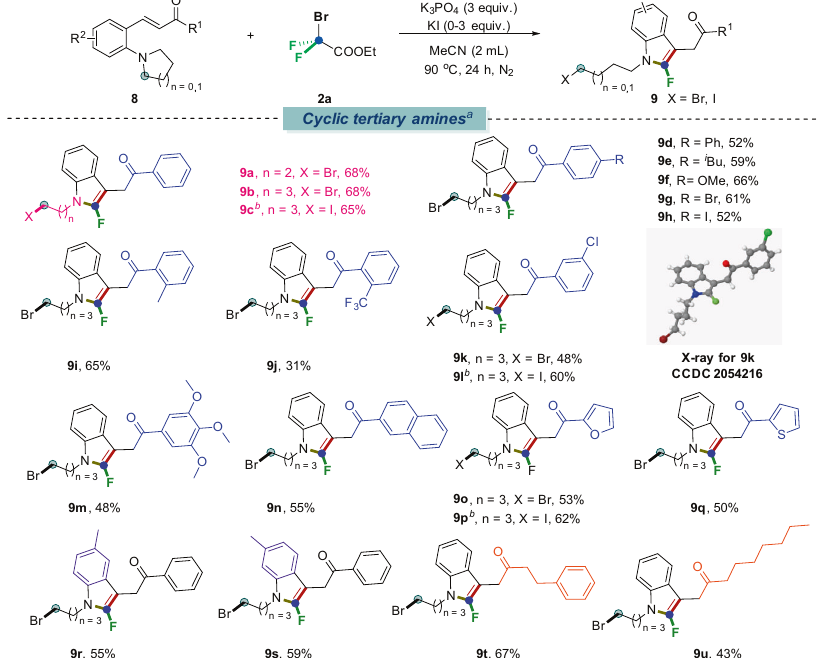
Fig. 4 Scope of cyclic tertiary anilines. Reaction conditions: a 8 (0.2 mmol), 2a (3 equiv., 0.6 mmol), K 3 PO 4 (3 equiv.), H 2 O (0.1 mL), CH 3 CN (2 mL) under 90 °C for 24 h, N 2 . b 8 (0.2 mmol), 2a (3 equiv., 0.6 mmol), KI (3 equiv.), K 3 PO 4 (3 equiv.), H 2 O (0.1 mL), CH 3 CN (2 mL) under 90 °C for 24 h, N 2